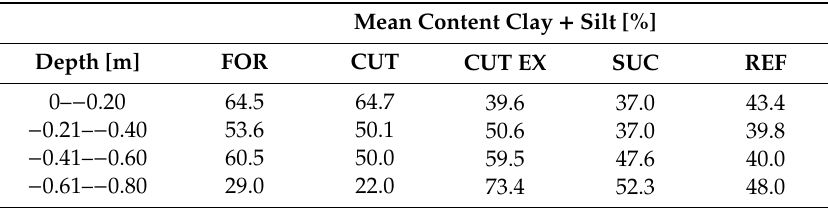
Figure 6. Clay and silt content dataset distribution. Table 4. Mean content clay + silt. Depth aggregated data.